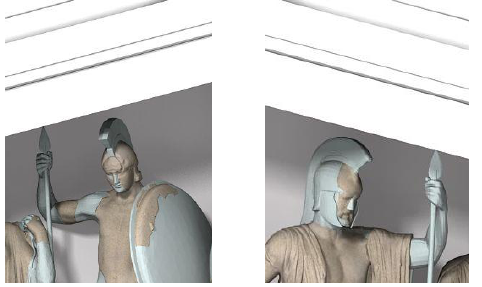
Figure 12. The spear-heads of the male figures in the open arrangement